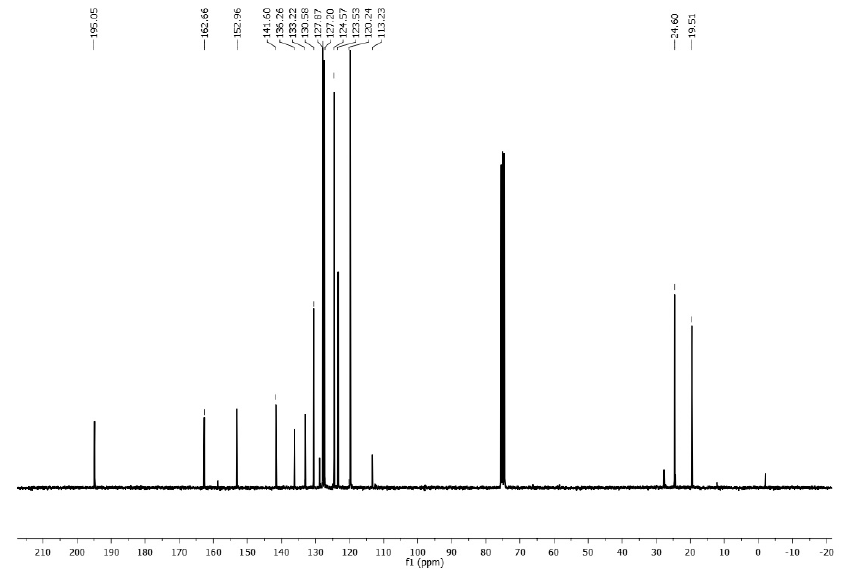
Figure 2. 13 C - NMR spectrum of imidate 3 . Figure 2. 13 C-NMR spectrum of imidate 3 .